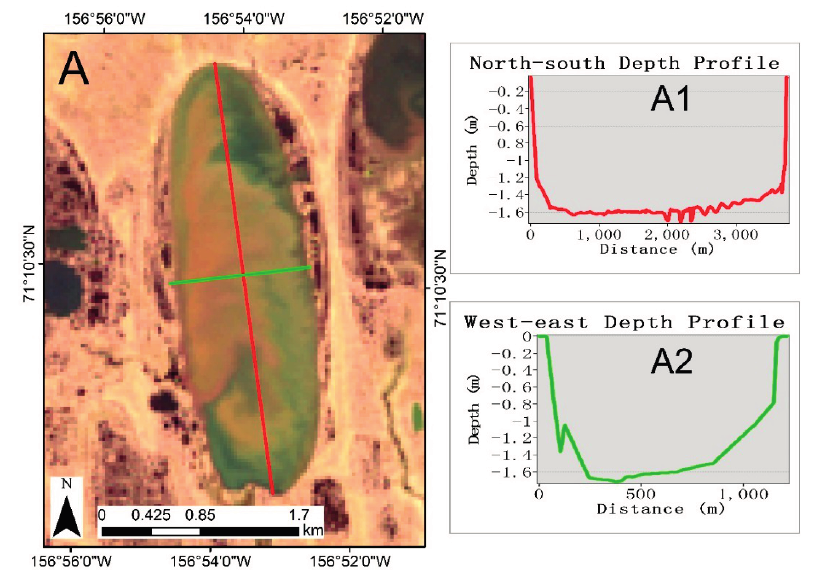
Figure 5. Landsat 8 images of two oriented thermokarst lakes ( A and B ) acquired on 10 July 2013. A1 , A2 and B1 , B2 show sonar-based bathymetry profiles in the north-south and west-east transects for lake A and B respectively (refer to [33] for the method of bathymetry measurements). All profiles indicate nearly flat lake bottoms. (Note the different x -axis and y -axis scales in different